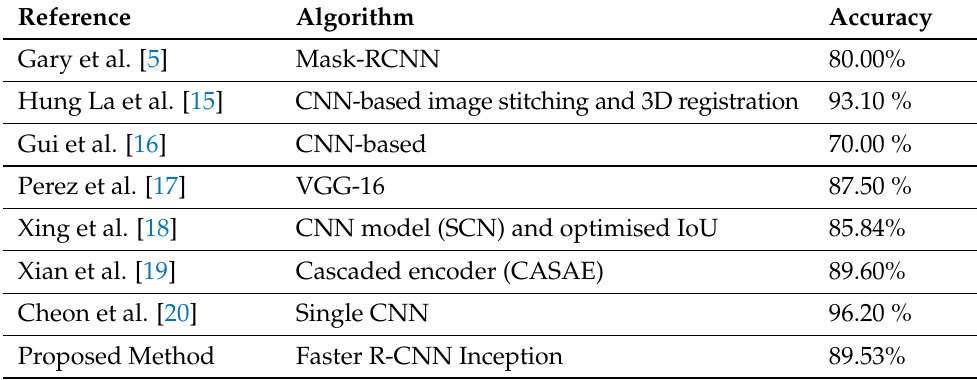
Table 10. Comparison of results with other methodologies in related